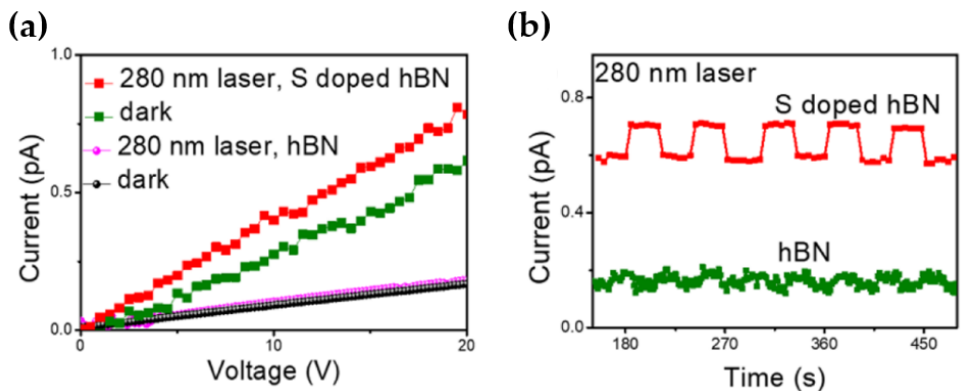
Figure 13. ( a ) I − V curves of hBN and S-doped hBN measured in the dark and 280 nm light irradiation at 20 V; ( b ) I − t curves of hBN and S-doped hBN under 280 nm light irradiation. (Reproduced with permission from ref. [181]; Copyright 2022 ACS Publications).